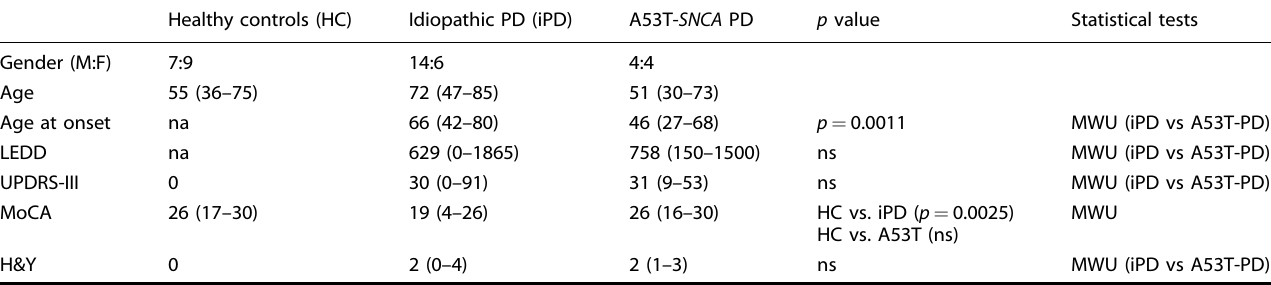
Table 1. Summary of demographics of study participants (Athens cohort). Healthy controls